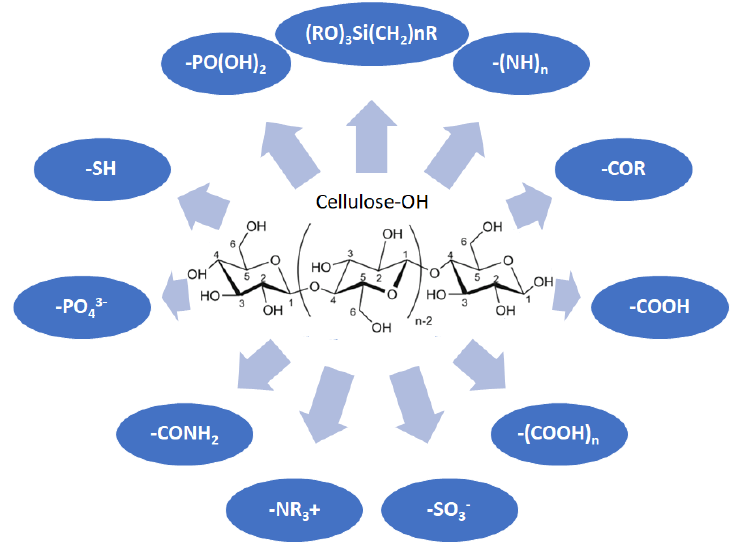
Figure 4. Chemical structure and modifications of interest for cellulosic-based materials.